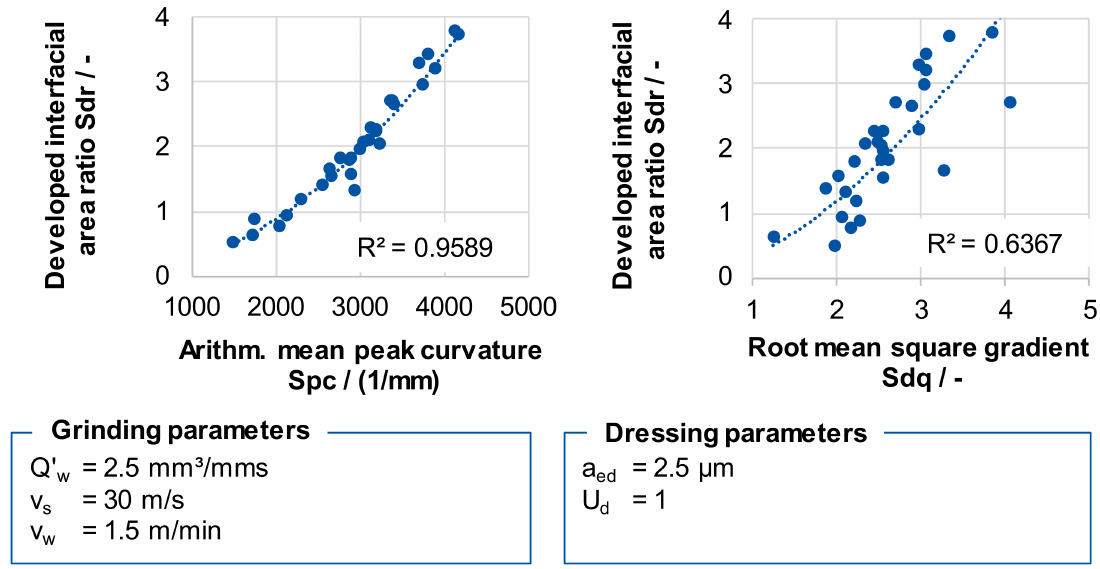
Figure 5. Correlation between the developed interfacial area ratio, the arithmetic mean peak curvature and the root mean square